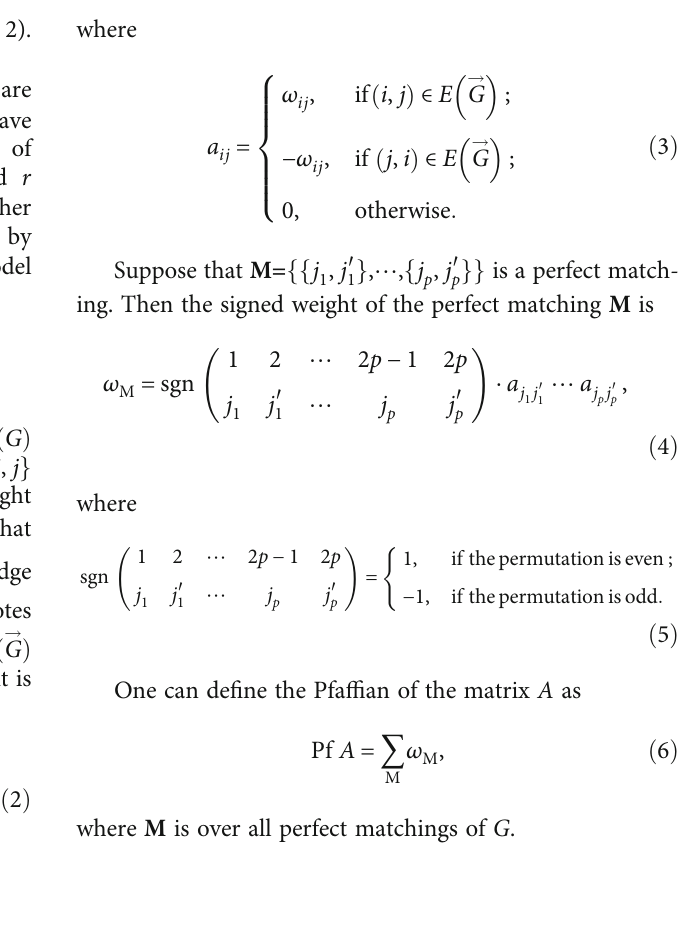
: (a) n is even and (b) n is 2 m , n , r